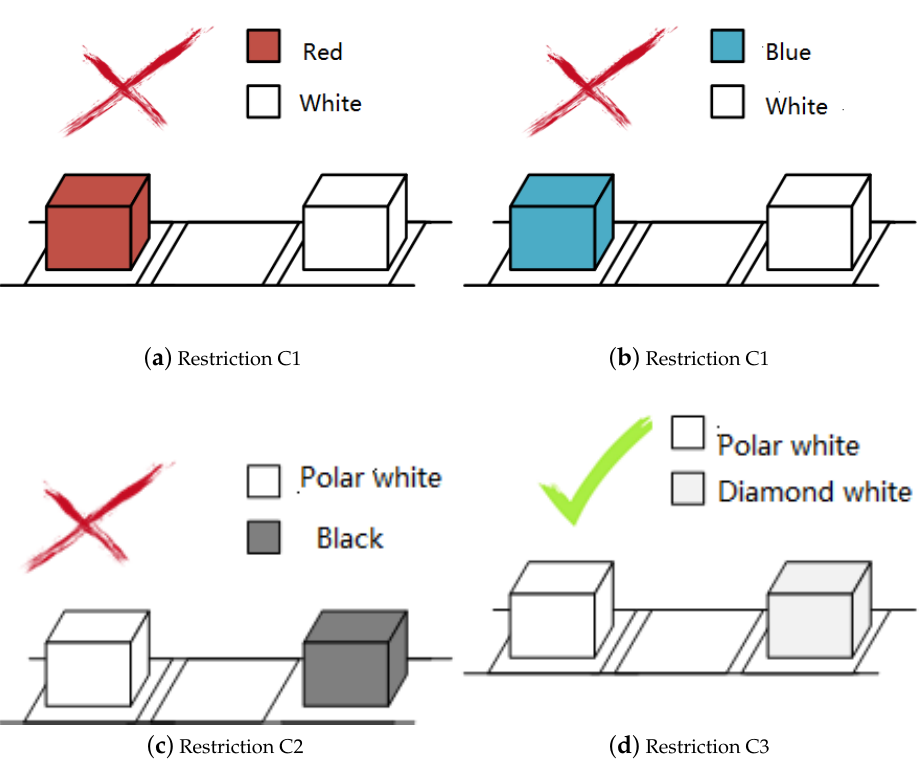
Figure 2. Restrictions on the sequences of